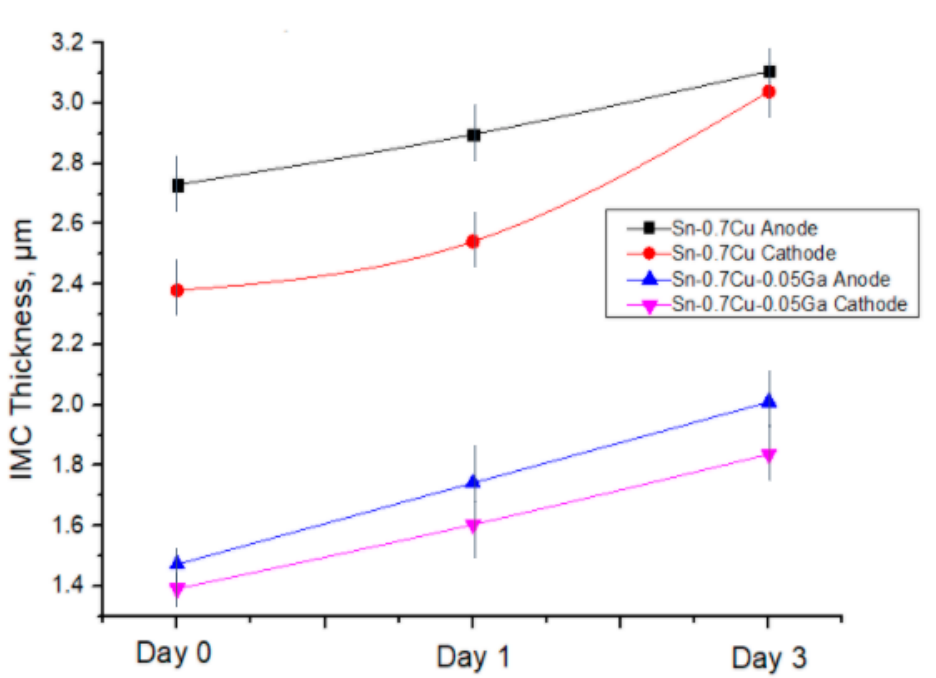
Figure 4. Average total IMC layer thickness of Sn–0.7Cu and Sn–0.7Cu–0.05Ga under room tempera- ture condition.